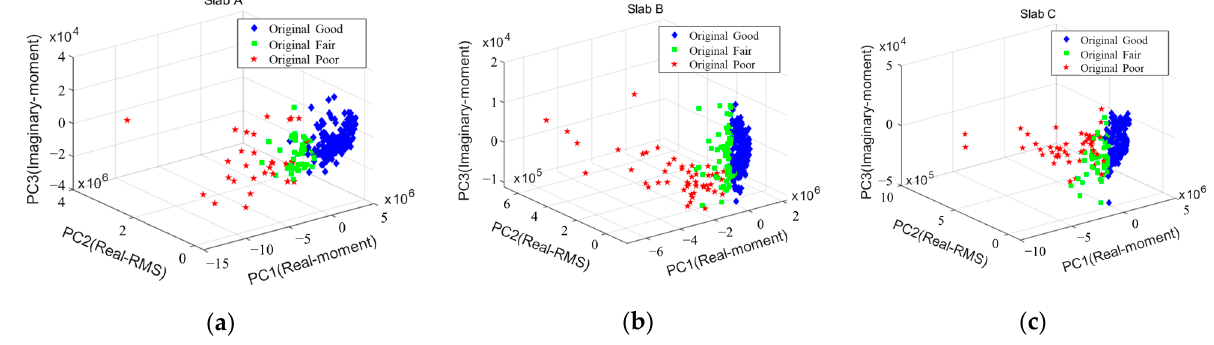
Figure 9. Three-dimensional plot of three principal components using PCA for each slab: ( a ) slab A, ( b ) slab B, ( c ) slab C.